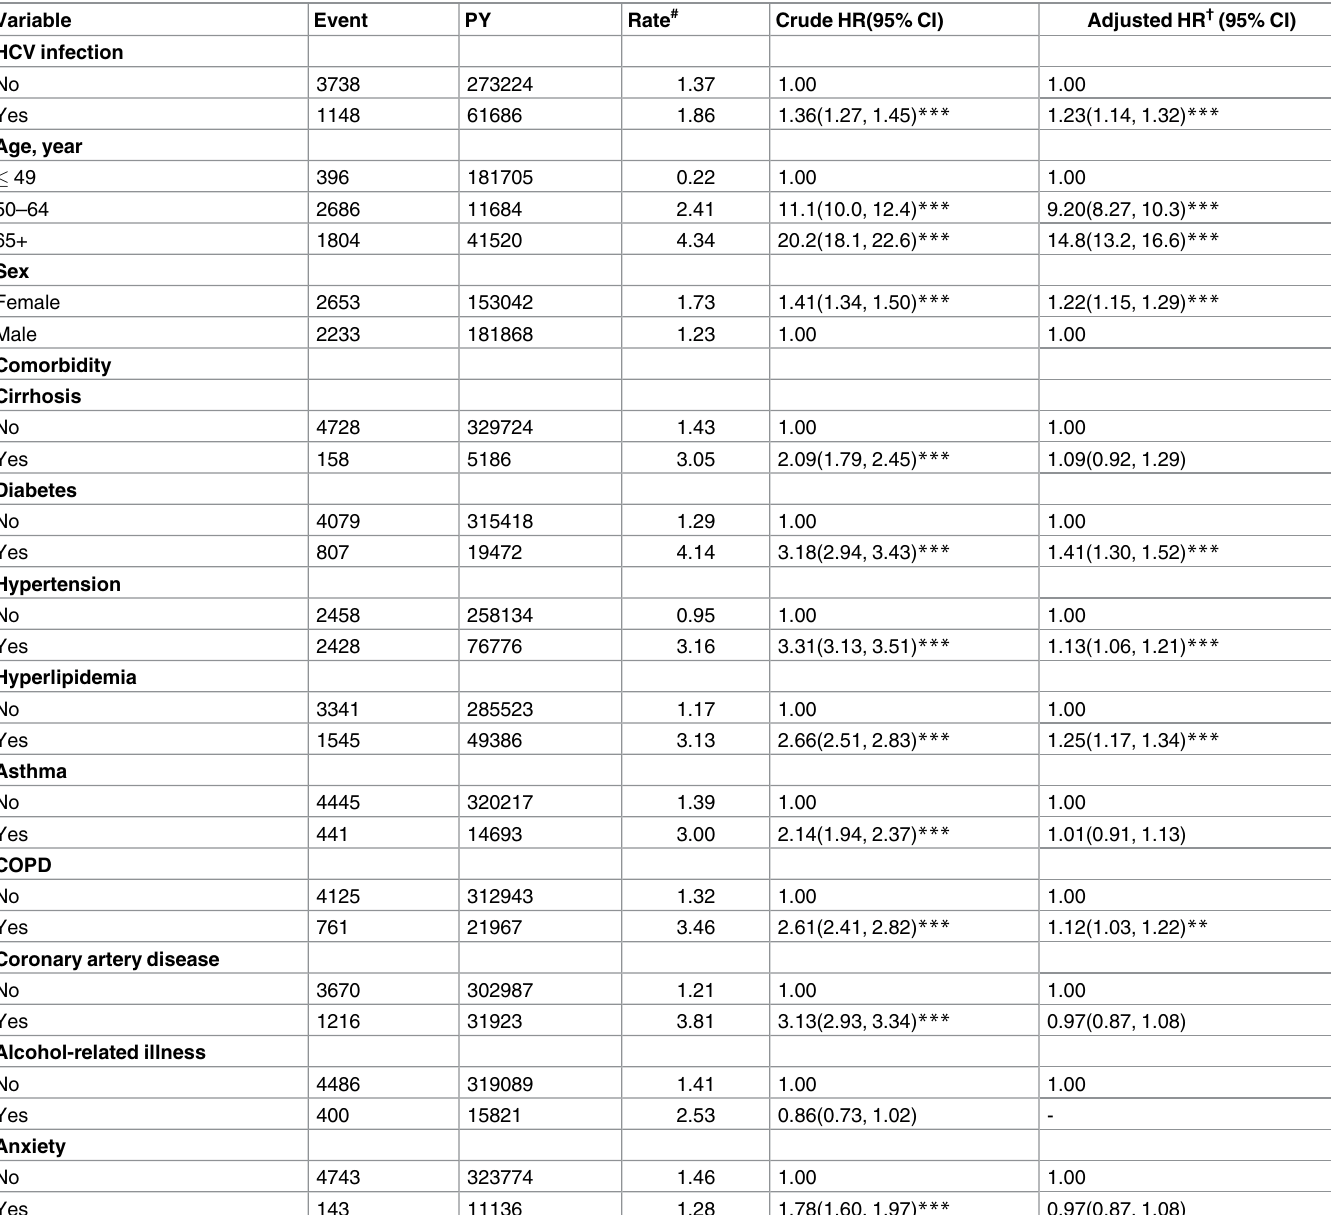
Table 2. The incidence and hazard ratio for cataractand cataract-associated risk factor.